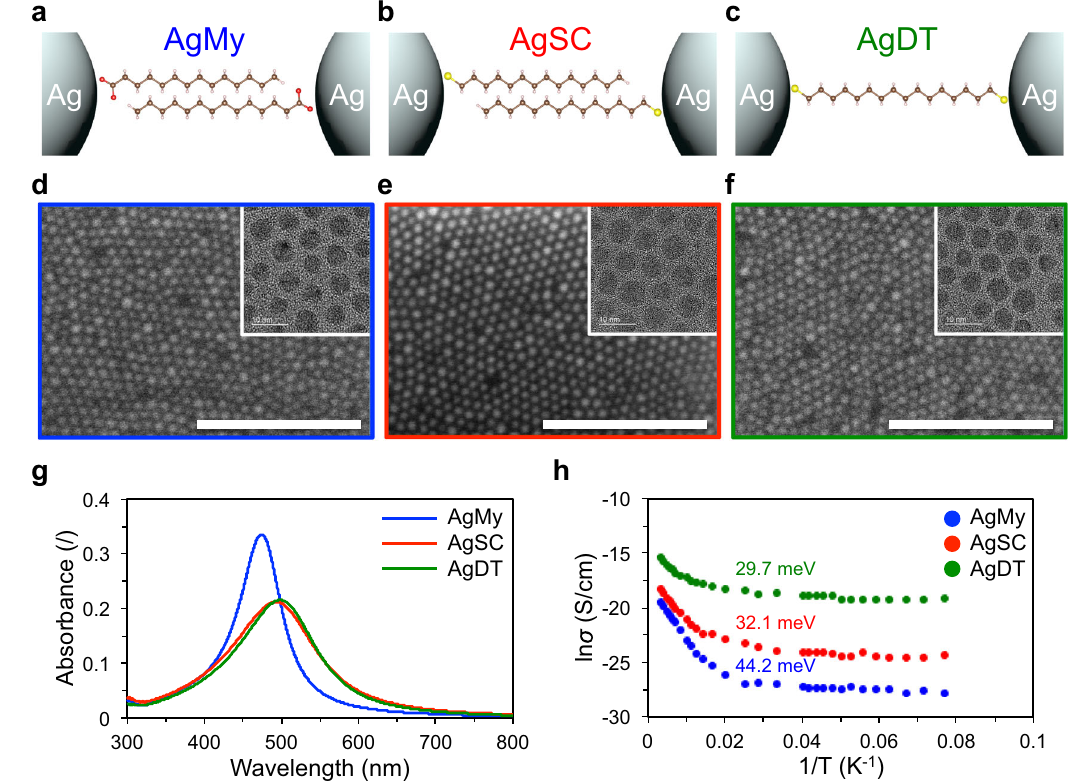
Fig. 1 Physical properties of AgMy, AgSC, and AgDT fi lms. a – c Schematic illustrations of each ligand: a myristate (My), b 1-tetradecanethiol (SC), and c 1.16-hexadecanidithiol (DT). d – f SEM images of each Ag nanoparticle monolayer fi lm: d AgMy, e AgSC, and f AgDT. Scale bars correspond to 100 nm and the inset fi gures are TEM images of each fi lm. For all fi lms, the same particle size (radius r = 2.4 nm) and interparticle distance (edge-to-edge d = 1.9 nm) are observed, because the immersion method provides ligand displacements, while maintaining the interparticle distance in a fi lm. g Plasmon resonance spectra of the AgMy (blue), AgSC14 (red), and AgDT16 (green) monolayer fi lms. h Arrhenius plots of conductivity for the AgMy (blue), AgSC14 (red), and AgDT16 (green) monolayer fi lms. Details of how to estimate E a are described in the Supplementary Information (see Supplementary Fig.